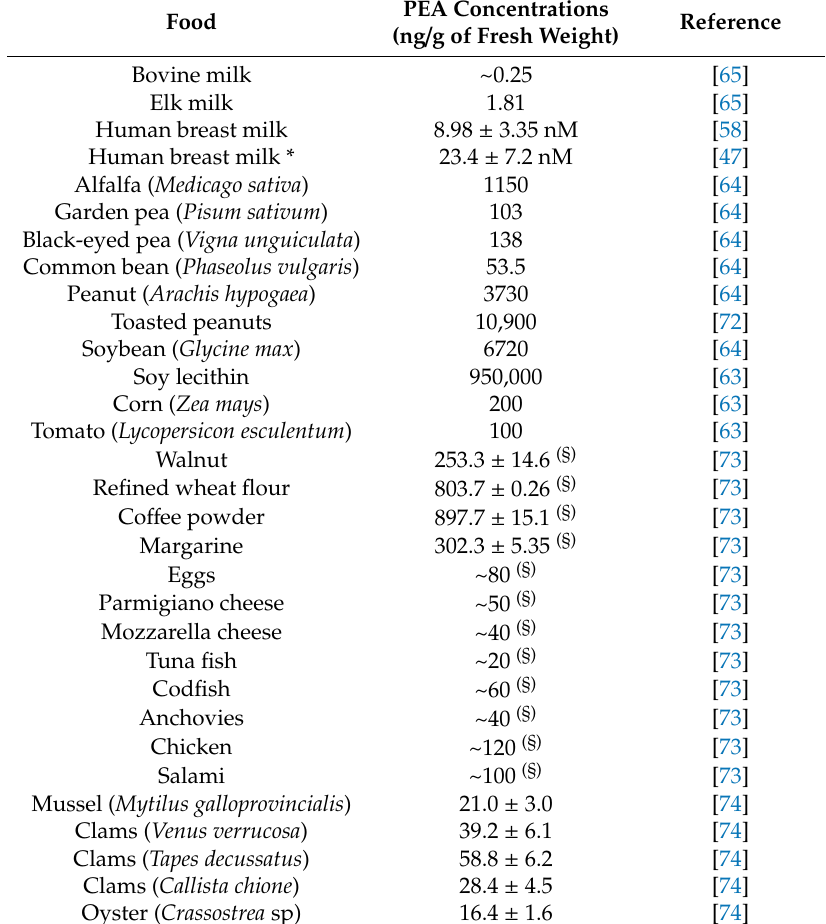
Table 1. PEA content in plant and animal derived foods. * 110 ± 32.3 lactation days; (§) on a dry weight